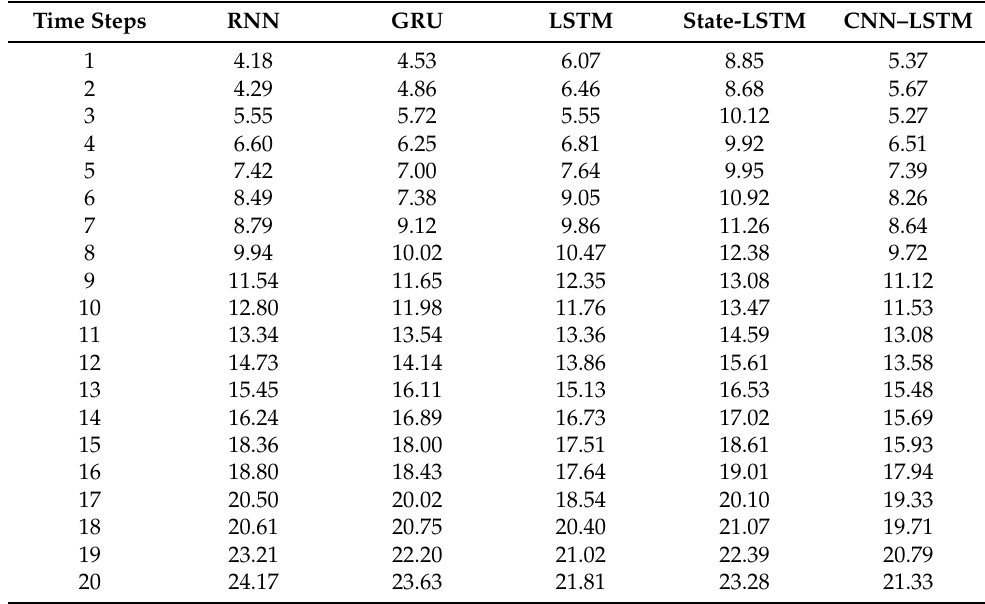
Figure 5. Field data and predicted position. ( a ) Train position curve in the 0.2 s. ( b ) Train position curve in the 2.0 s. Table 1. The RMSE performance comparison of trajectory prediction.